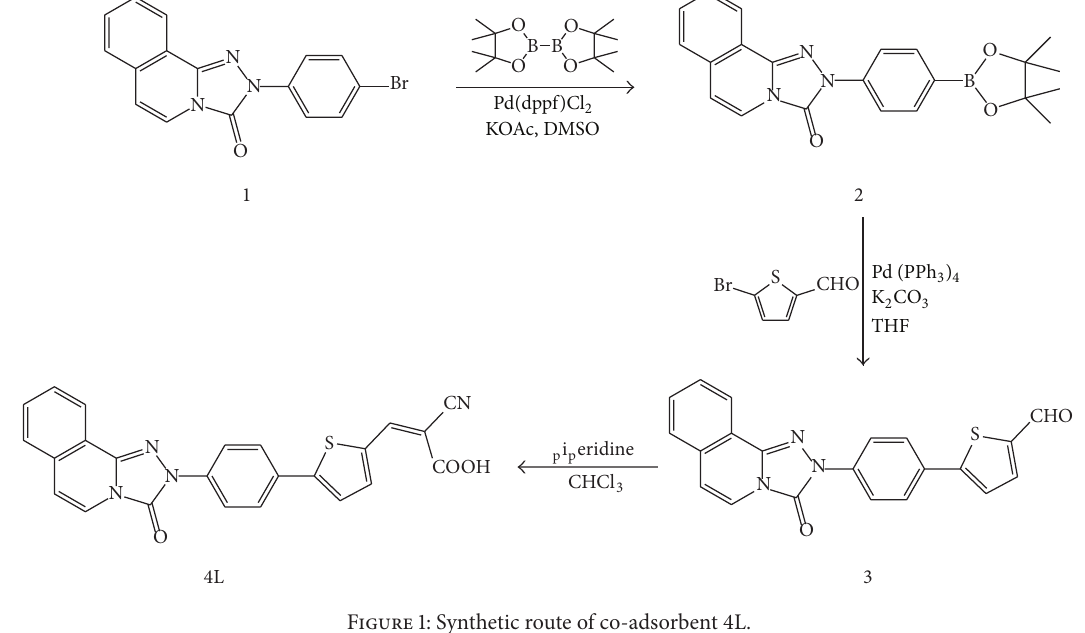
Table 1: The amount of adsorbed N719 dye for different TiO